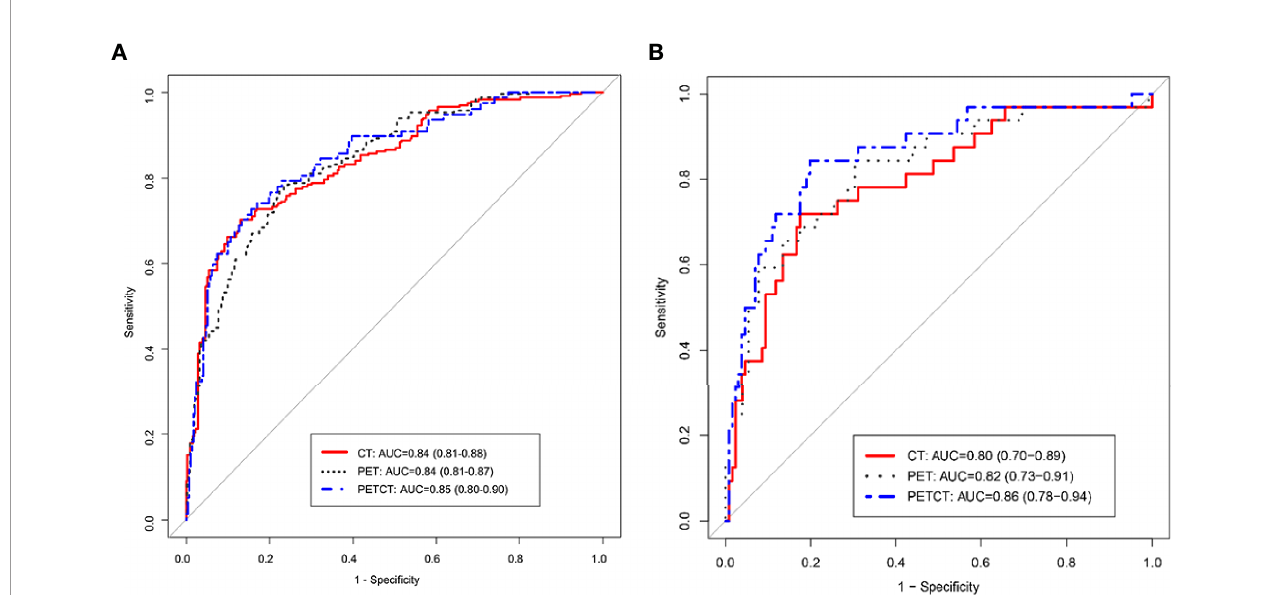
FIGURE 4 | ROC curve analysis of three radiomics models, PET/CT, CT, and PET in training group (A) and testing group (B) ,